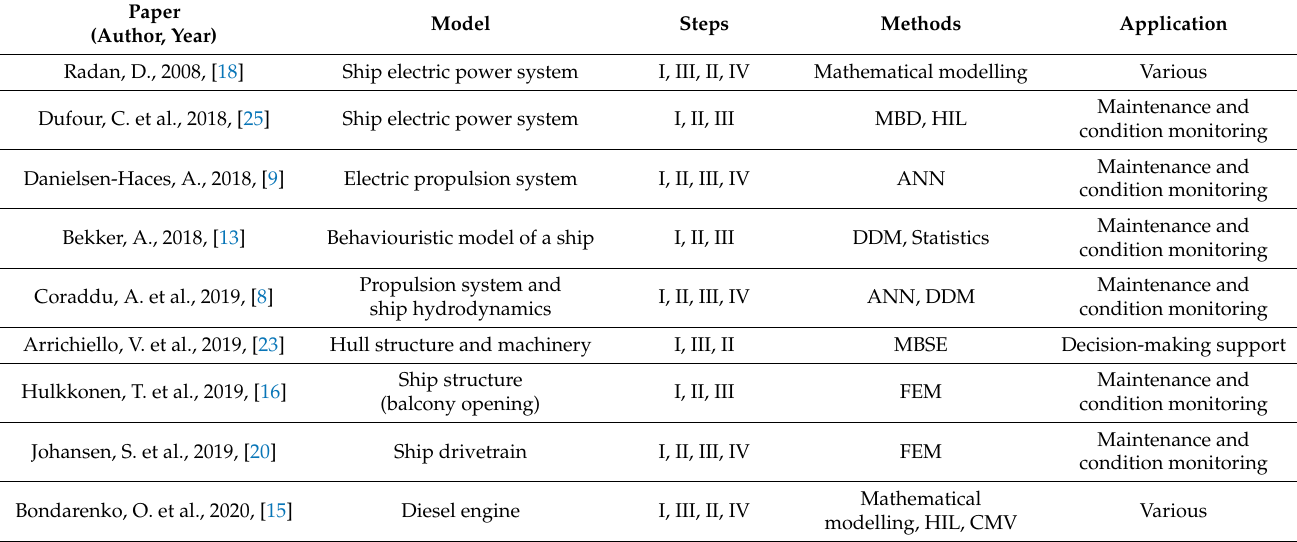
Table 1. The review analysis of DT models, formulation steps, methods, and